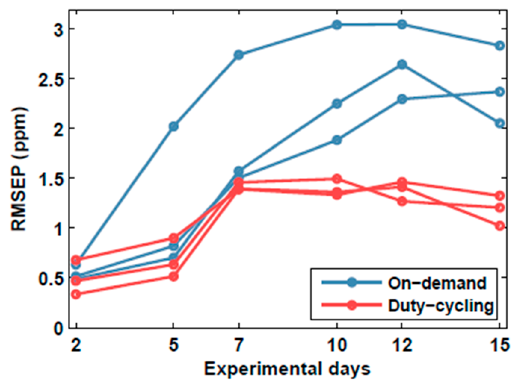
Figure 7. Discontinuous calibration. Score plot of the orthogonal PLS models obtained from one sensor of each group of discontinuously operated sensors. The title of the subplot indicates the target operating mode: ( a ) duty-cycling and ( b ) on-demand. The filled and open circles represent the calibration and validation observations, respectively. Hand drawn ellipses cluster observations of the same concentration level. The concentration (ppm) is indicated in the text at the top of the figure.